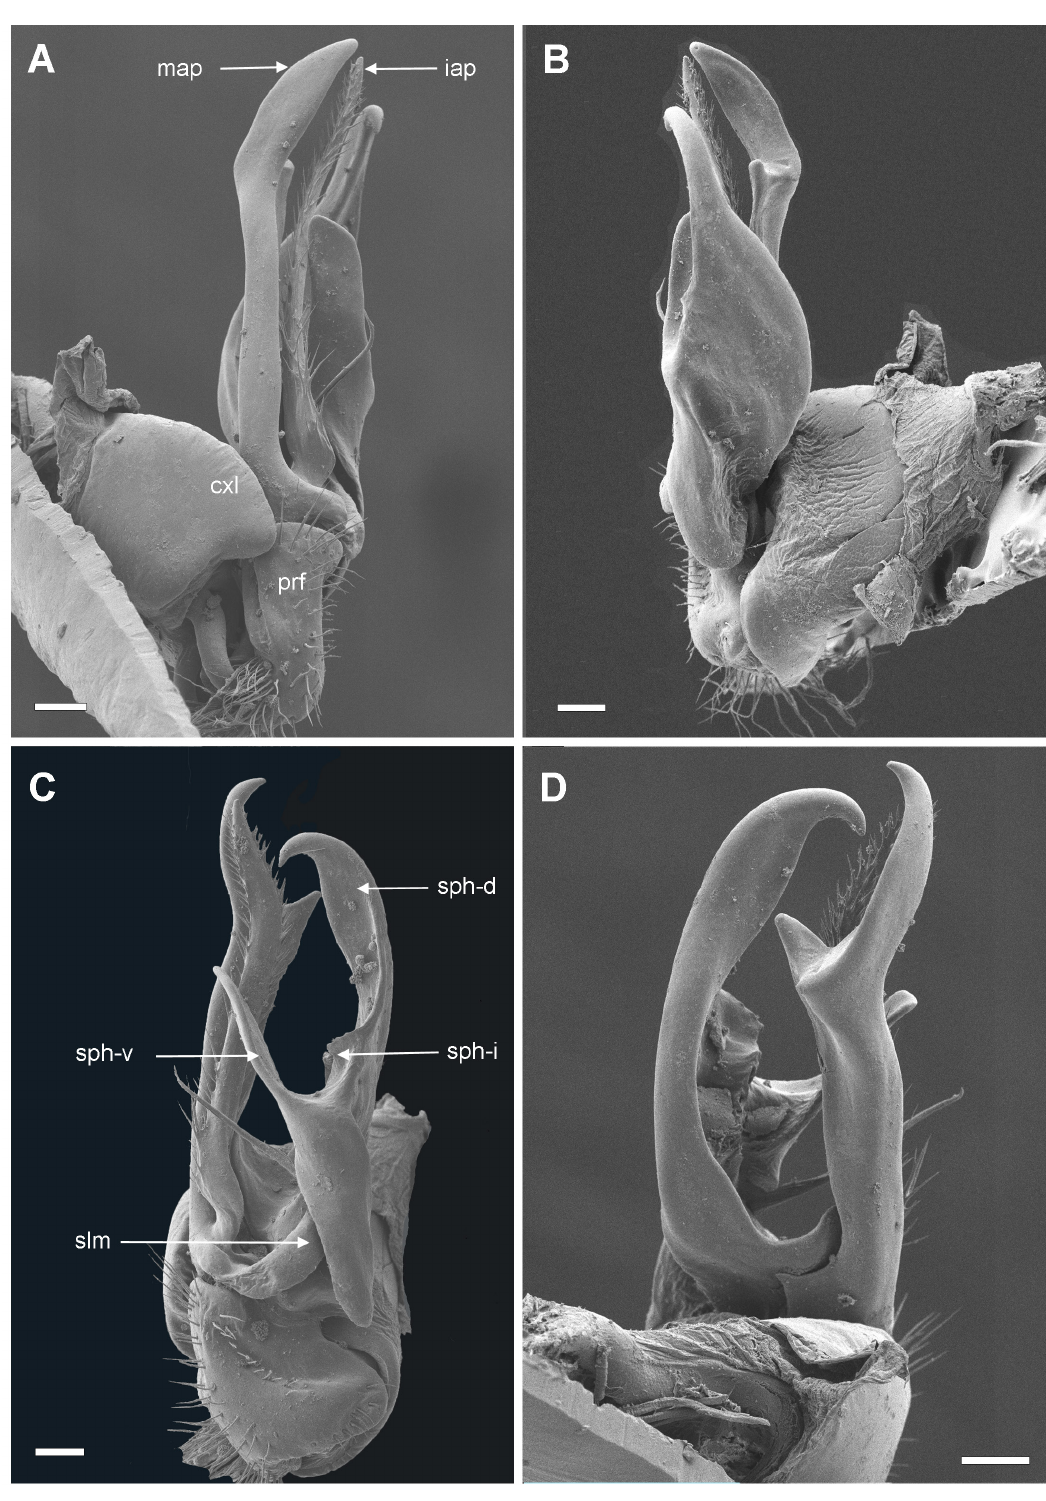
Fig. 16. Eviulisoma ejti sp. nov., paratype, left gonopod. A . Mesal view. B . Lateral view. C . Ventral view. D . Dorsal view. Aluminium tape used for mounting visible in lower left corner of A and D. Abbreviations: cxl = coxal lobe; iap = intermediate acropodital process; map = mesal acropodital process; prf = prefemoral part; slm = solenomere; sph-d , sph-i , sph-v = dorsal, intermediate and ventral lobes of solenophore. Scale bars: 0.1